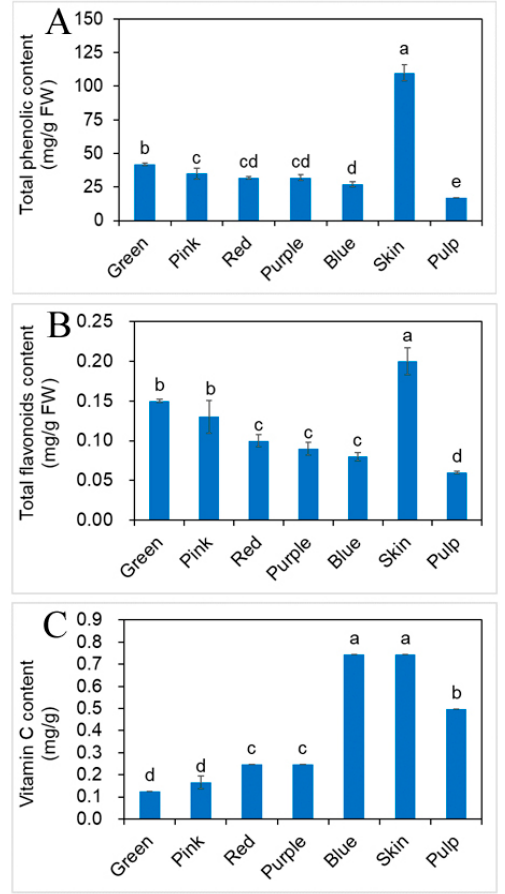
Figure 2. Changes of the contents of phytochemical profiles for blueberry at different developmental stages of fruit, skin and pulp. ( A ) Total phenolic content; ( B ) total flavonoids content; ( C ) vitamin C content (mean ± SD, n = 3). Bars with different letters differ significantly ( p <